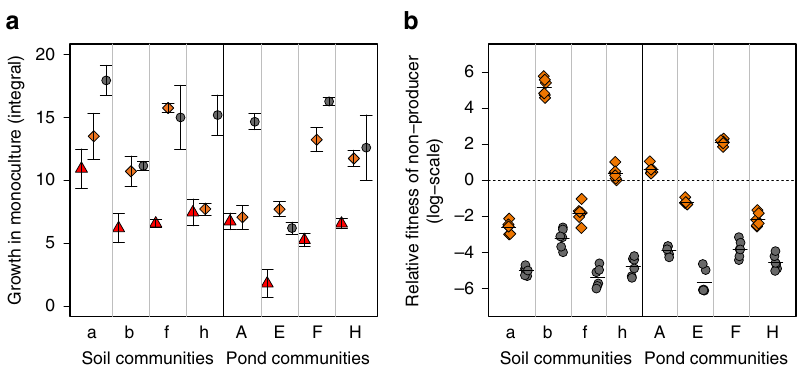
Fig. 5 Direct competition between pyoverdine producers and non-producers reveal both cheating behaviour and resistance to cheating. a When grown as monocultures, the eight pyoverdine non-producers grew signi fi cantly worse than the pyoverdine producers, showing that the inability to produce pyoverdine represents a handicap in iron-limited CAA medium. Growth of non-producers ( red triangles ) tagged with a neutral constitutive mCherry marker was compared to growth of the strains producing a pyoverdine type that can ( orange diamonds ) or cannot ( grey circles ) be used by the respective non- producers for iron uptake. Data points show means ± 95% con fi dence intervals across three replicates. b Direct competition between non-producers and producers revealed three different scenarios. When competing against producers that secrete a compatible pyoverdine ( orange diamonds ), non-producers could win the competition in four cases. In the other four cases, non-producers could not outcompete producers despite being able to use the producer ’ s pyoverdine. Finally, when competing against producers that secrete an incompatible pyoverdine ( grey circles ), non-producers were always strongly outcompeted. The dashed line depicts fi tness parity, whereas values greater or smaller than zero indicate cases where non-producers or producers won the competition, respectively. While symbols show individual data points, bars depict means across six replicates. Data were ln-transformed prior to